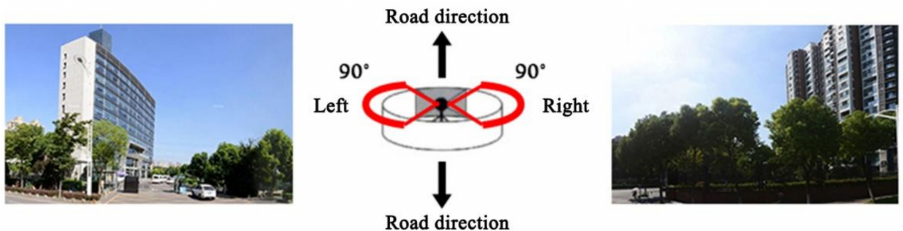
Figure 2. Street-level imagery acquisition at the sampling point.